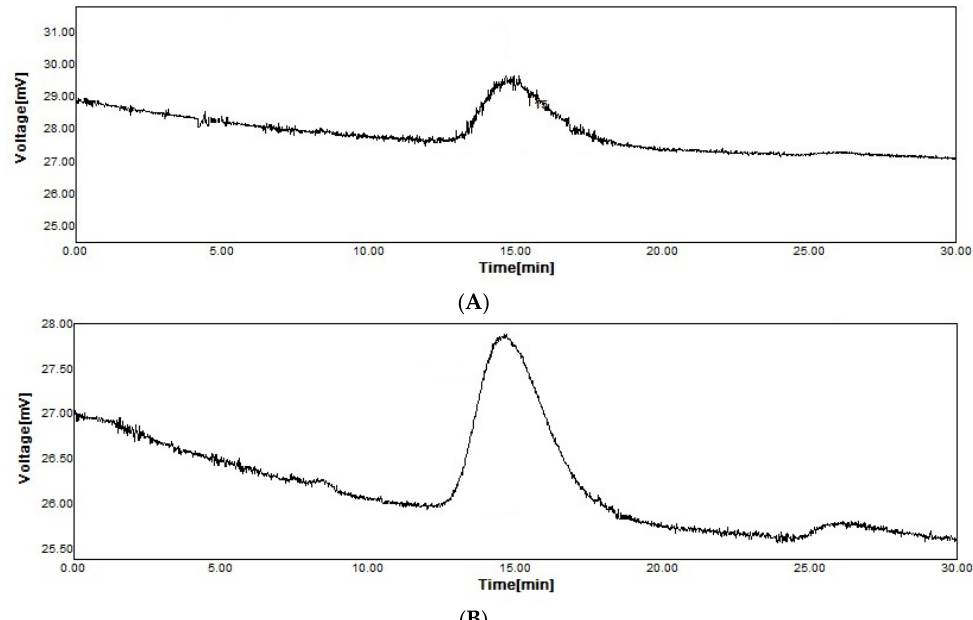
Figure 7. ( A ) Gas chromatogram of ethanol production from 30 g/L of chitin oligosaccharides using M. circinelloides. ( B ) Gas chromatogram of ethanol production from 50 g/L of chitin oligosaccharides using M. circinelloides.